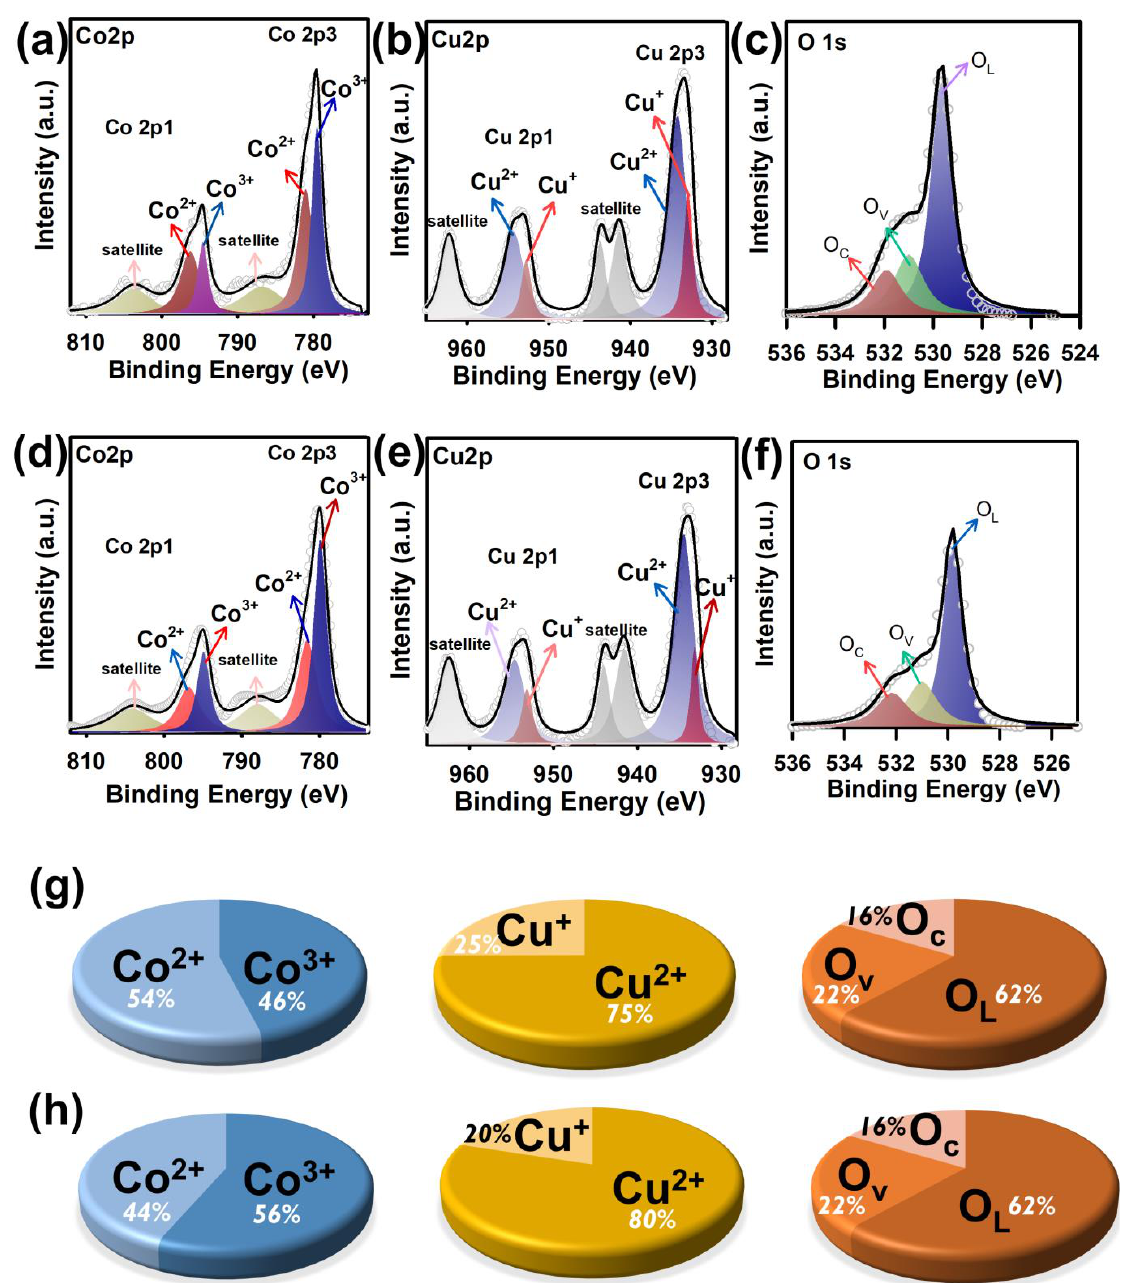
Figure 7. XPS analyses: ( a – c ) pristine FCCM, and ( d – f ) used FCCM; fractions of species in the ( g ) pristine and ( h ) spent FCCM.